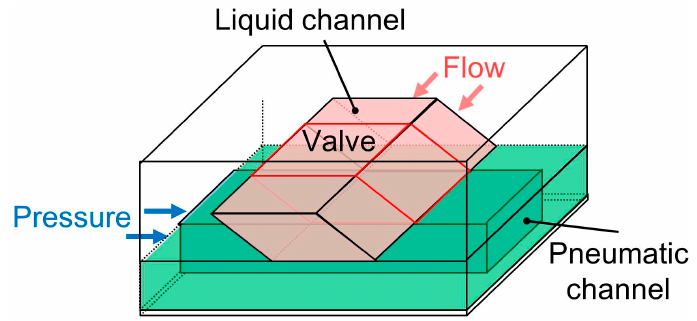
Figure 2. Operating principle of the proposed pneumatic microvalve for a tall microchannel. ( a ) Open; ( b ) Closure of the acute angle; ( c ) Closure of the obtuse angle.